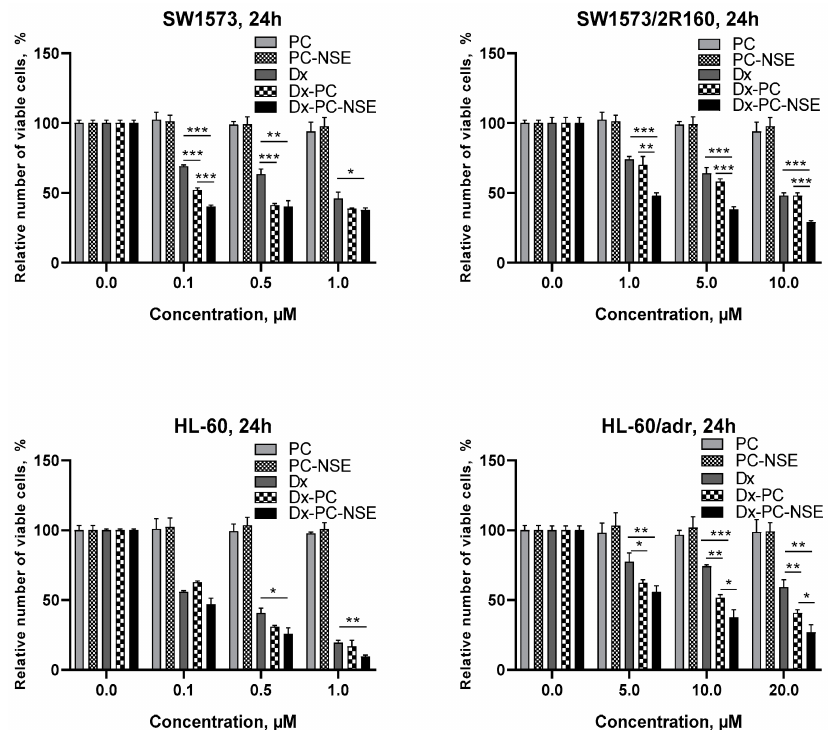
Figure 5. Comparison of the cytotoxic activity of polymeric micelles with immobilized Dx and/or NSE in vitro towards human SW1573 non-small lung cancer cells and its drug-resistant subline SW1573/2R160 (ABCB1+), and human leukemia HL-60 together with its Dx-resistant subline HL-60/adr (ABCC1+).